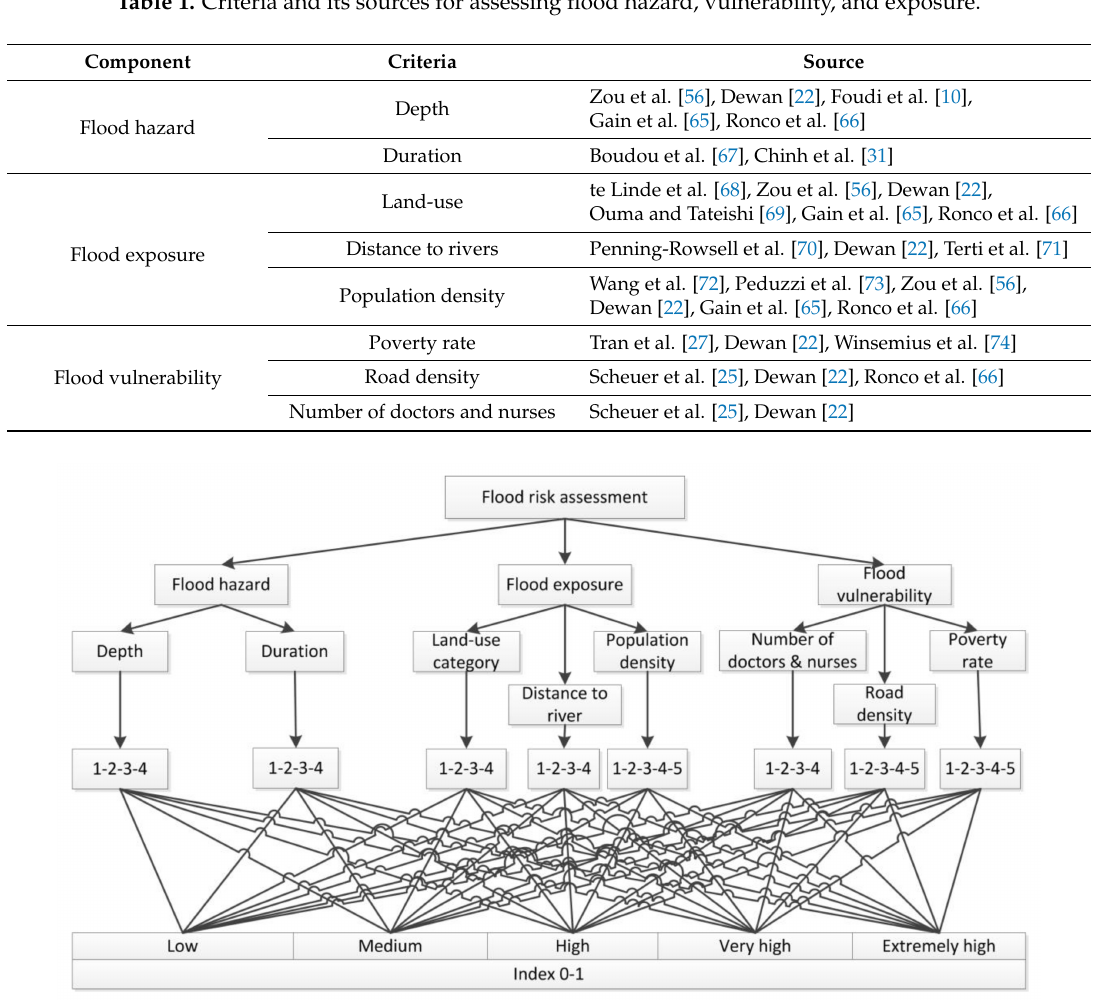
Figure 3. Decision hierarchy model to measure the flood risk for Quang Nam